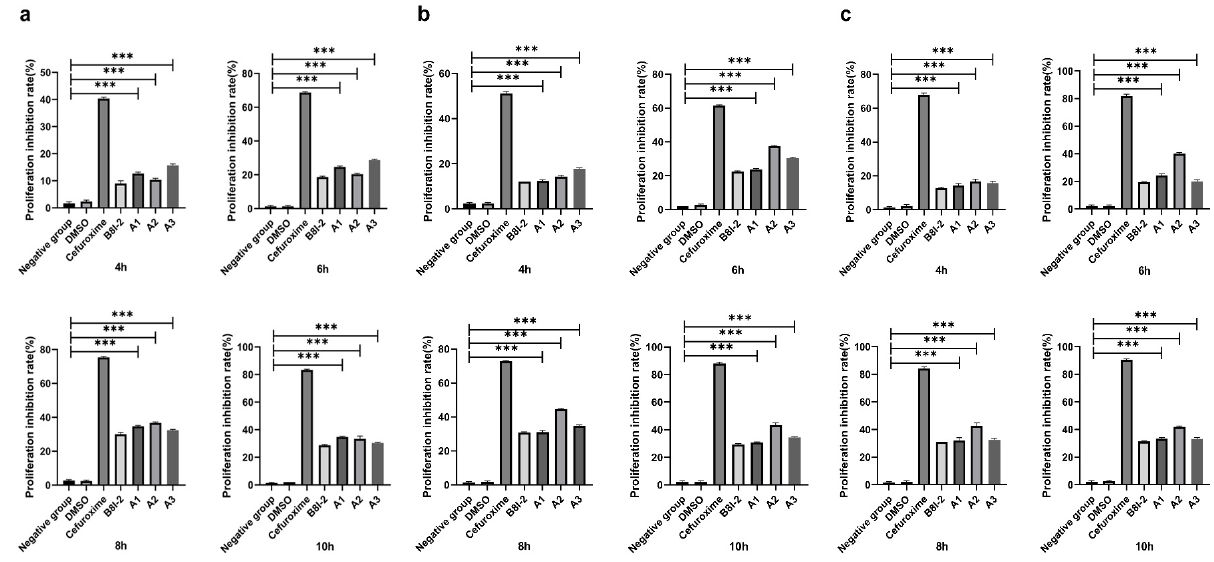
Figure 6. Antibacterial activity rate (%) of A1 – A3 treatment: ( a ) the antibacterial activity of the A1 – A3 on Agrobacterium tumefaciens with di ff erent times at 30 µmol/L; ( b ) the antibacterial activity of the A1 – A3 on Agrobacterium tumefaciens with di ff erent times at 50 µmol/L; and ( c ) the antibacterial activity of the A1 – A3 on Agrobacterium tumefaciens with di ff erent times at 100 µmol/L. Data represent the mean ± standard deviation (SD) of three independent experiments; *** represents p < 0.001.